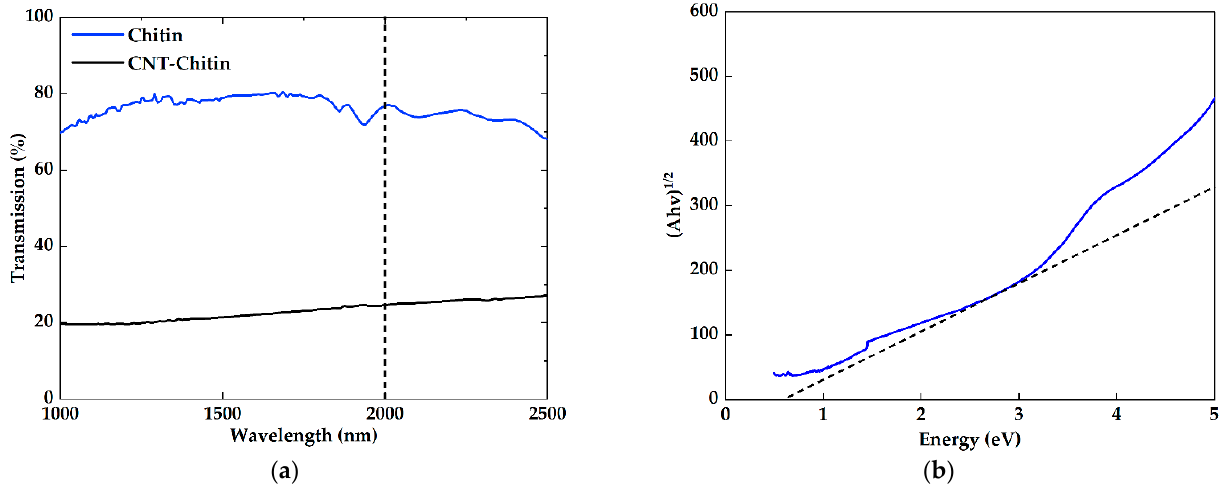
Figure 3. ( a ) Transmission spectrum and ( b ) Tauc relation of CNT–chitin film.